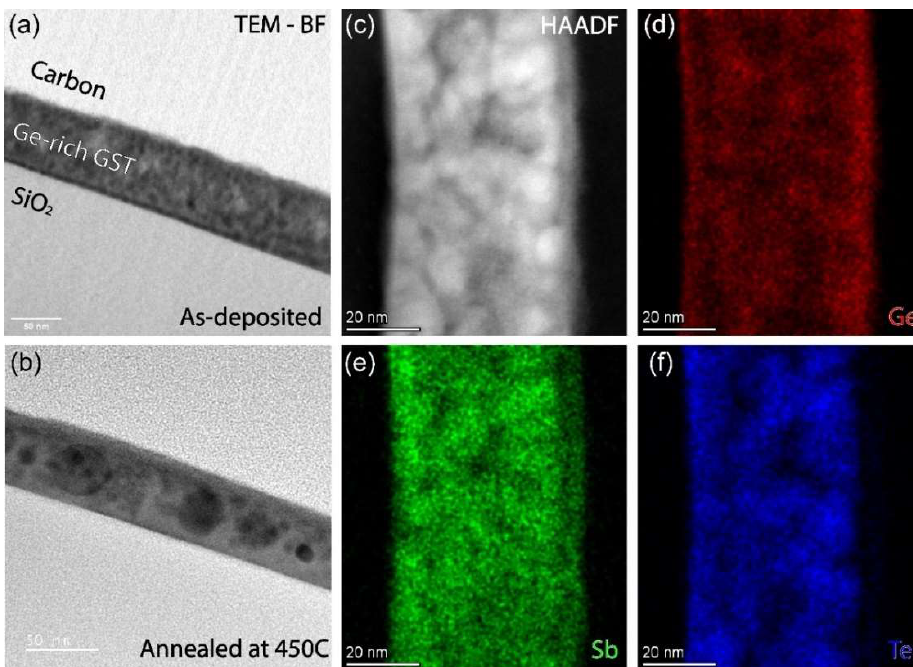
Figure 4. BF-TEM images of Ge-rich GST thin film in ( a ) as-deposited phase and ( b ) after annealing at 450 °C for 30 min. High-angle annular dark-field (HAADF)-STEM image ( c ) and STEM-EDX chemical compositions of ( d ) Ge, ( e ) Sb, and ( f ) Te for the annealed Ge-rich GST sample.